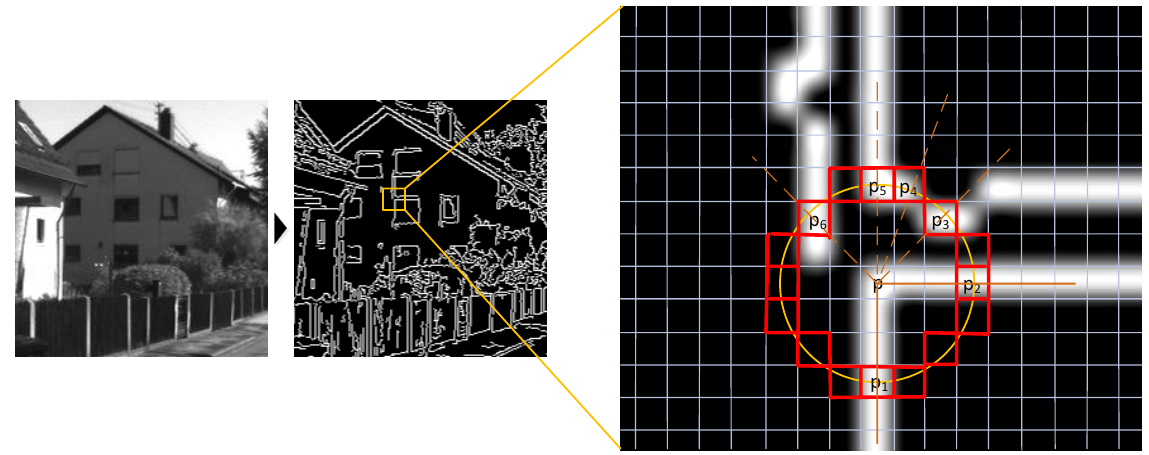
Figure 3. An example of the L-FAST idea.